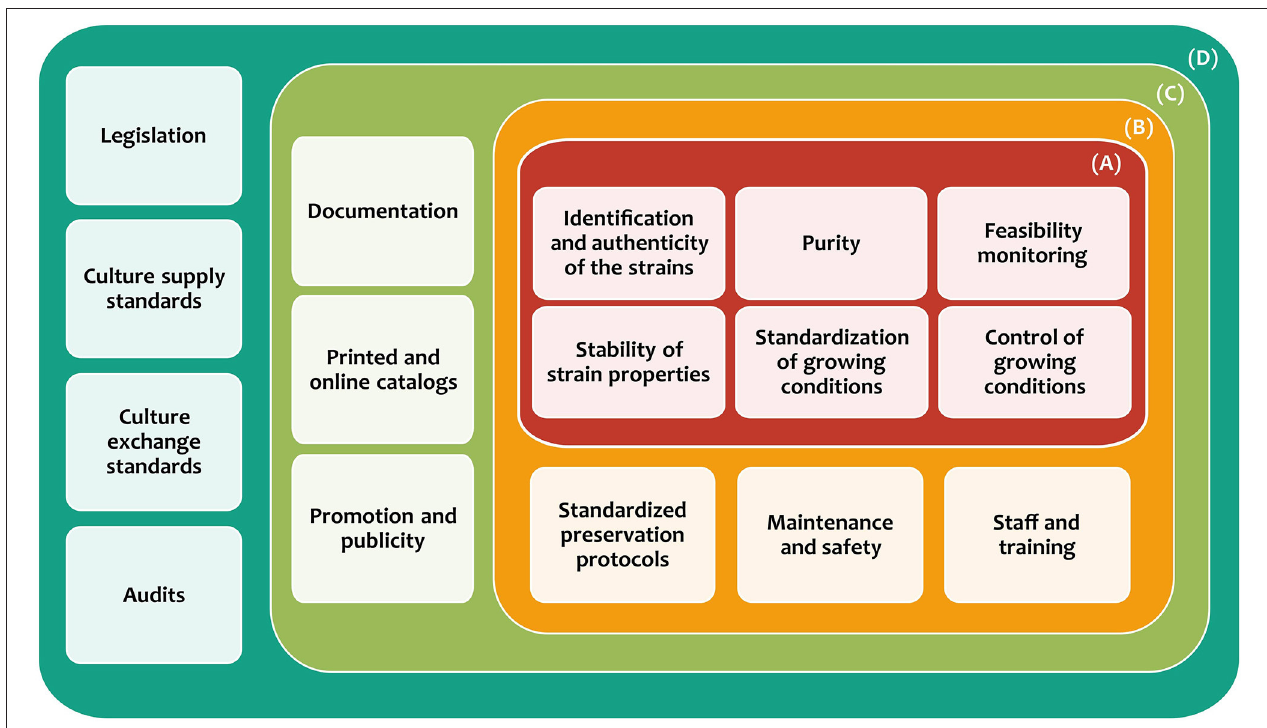
FIGURE 2 | Categories and requirements for the establishment and maintenance of microbial culture collections. (A) Microbial culture characterization and authentication, (B) establishment of protocols, (C) diffusion, and (D) policies and